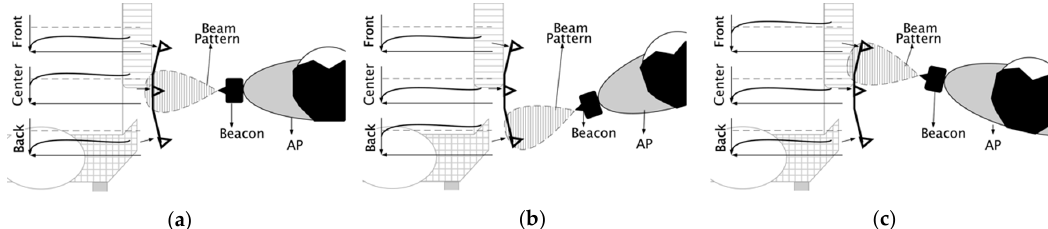
Figure 4. Ultrasonic transducer analog output while the person is ( a ) walking and stopping, ( b ) turning right, ( c ) turning left. Dashed line is high threshold.